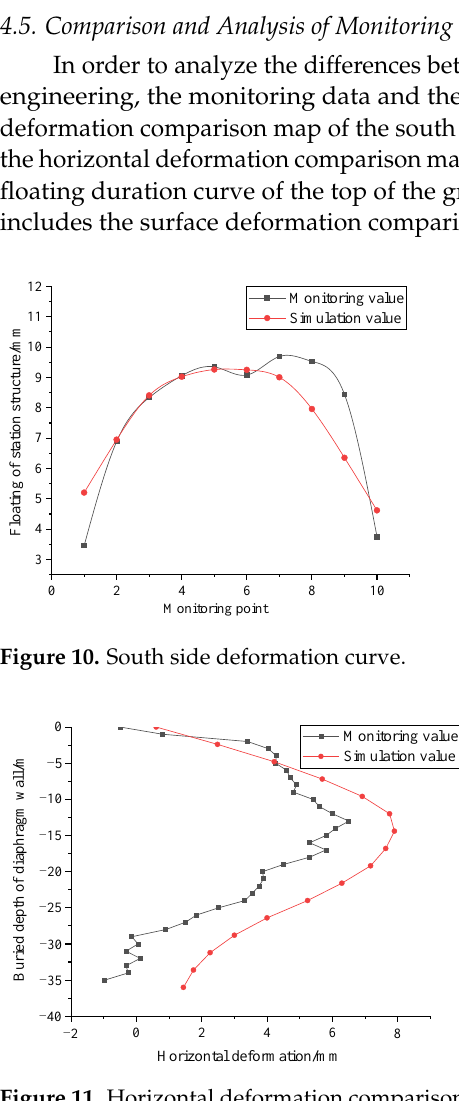
Date Figure 12. Floating time curve on the top of the wall.